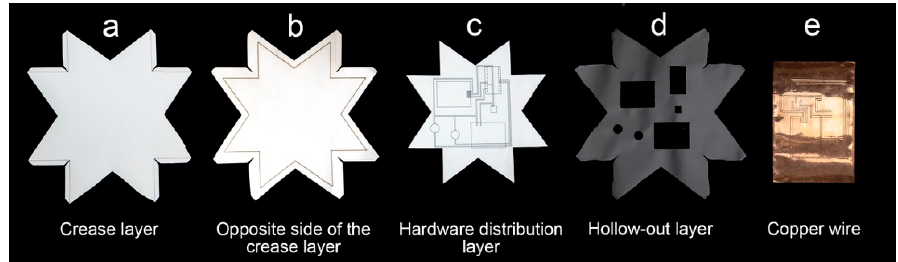
Figure 10. Materials that have been processed. ( a ) Crease layer; ( b ) opposite of the crease layer; ( c ) hardware distribution layer; ( d ) hollow ‐ out layer; ( e ) copper wire.